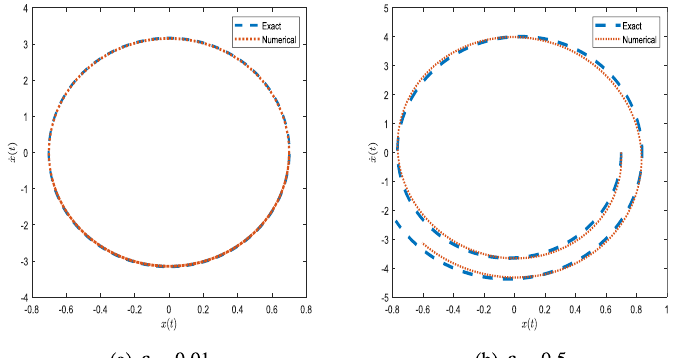
Figure 1. Phase plots with x 0 = 0.7 and ω = 4 .